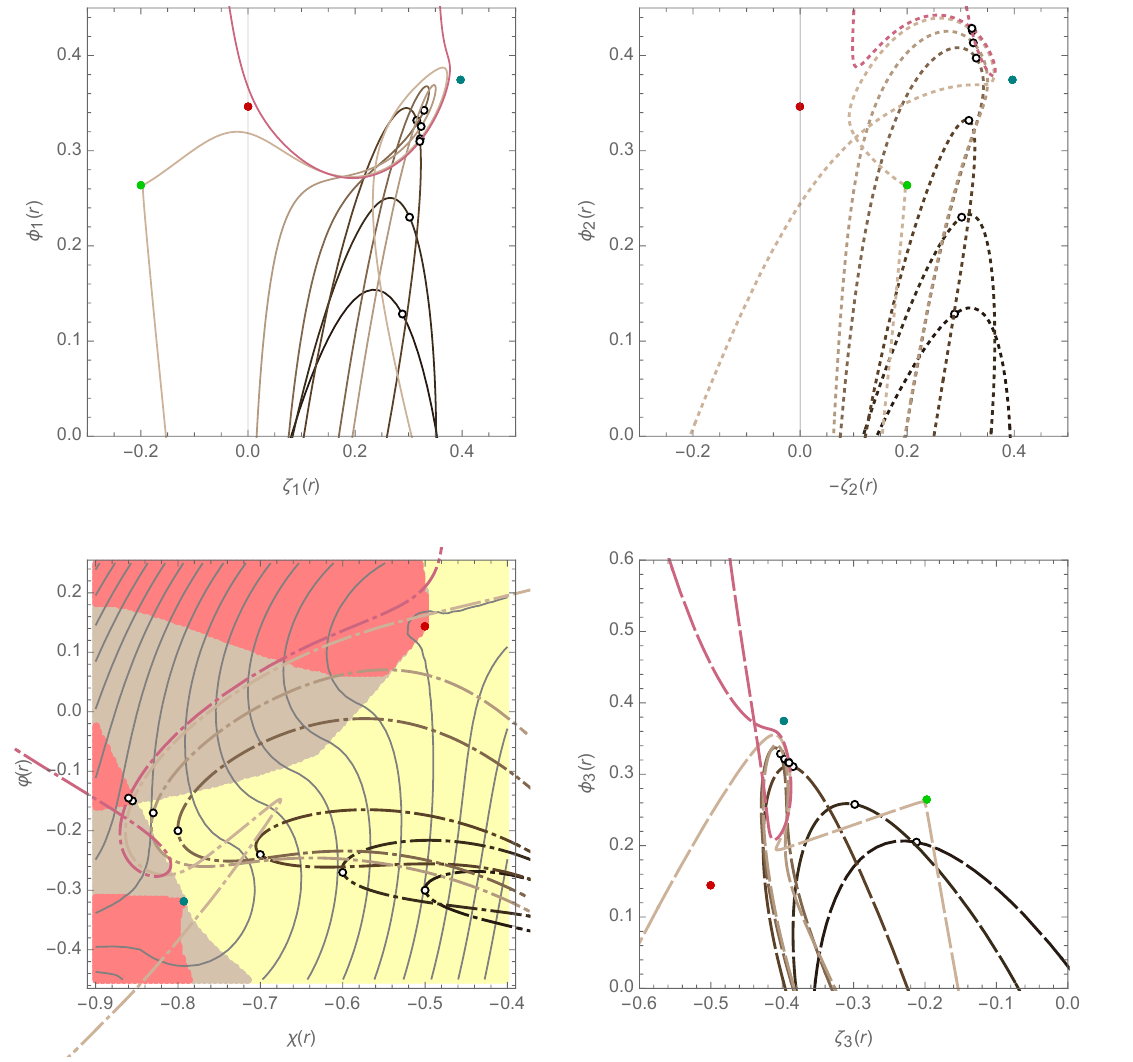
Figure 24. Space of N = 1 Janus solutions with SO(3) symmetry and turning points moving acorss the boundary between yellow, grey and red